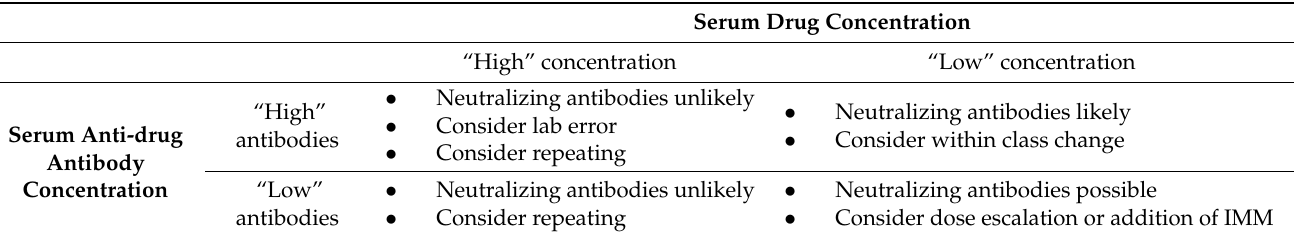
Table 1. Framework for evaluating detectable biologic trough concentration and detectable anti-drug antibodies. Serum Drug Concentration “High” concentration “Low”